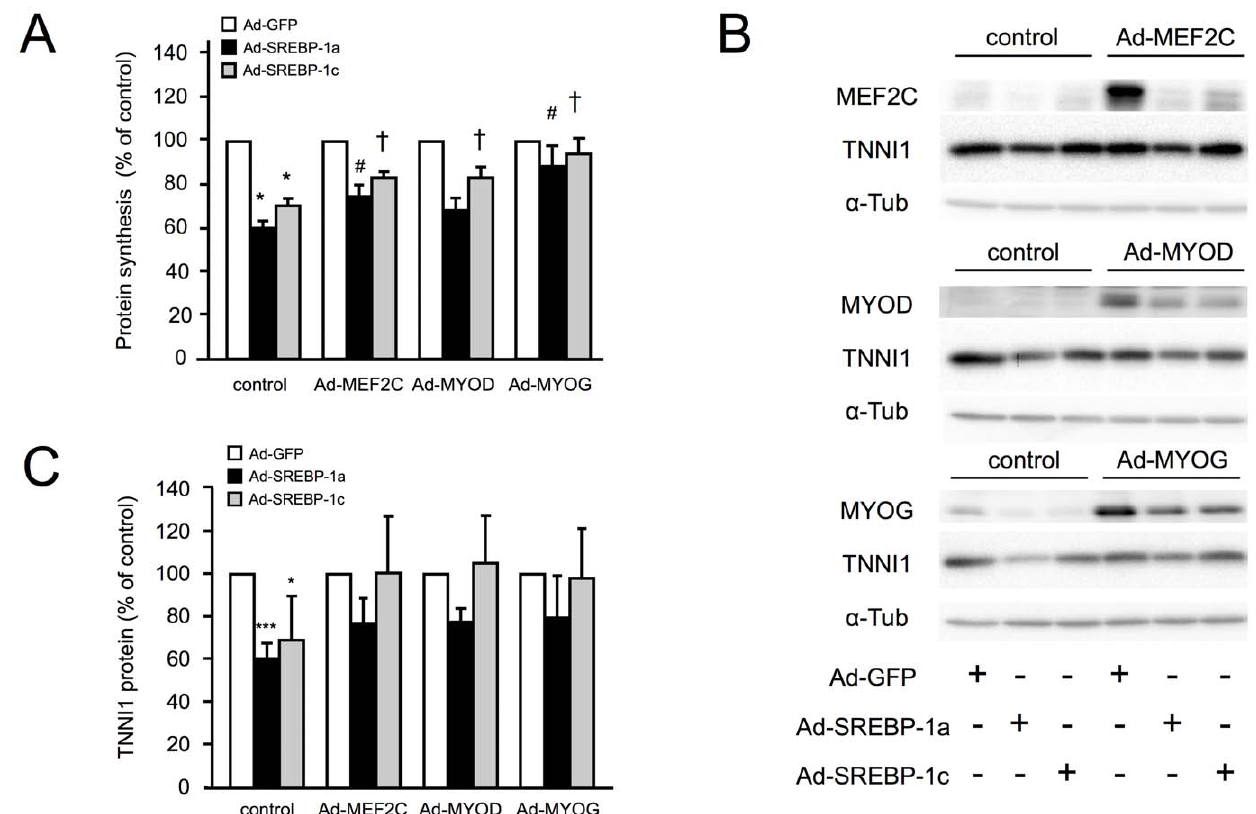
Figure 4. Expression of MEF2C, MYOD1 and MYOG are necessary to maintain muscle cell protein synthesis and expression of sarcomeric proteins. Human myotubes were infected for 48 h with recombinant adenoviruses encoding GFP (white), SREBP-1a (black) or SREBP-1c (grey) in combination with viruses expressing MEF2C, MYOD1, MYOG or GFP (control). (A) Protein synthesis rates were measured in all different conditions. The results are the means 6 SE of 5 determinations. *p , 0.001 compared to Ad-GFP infected cells. # p , 0.05 compared with Ad-SREBP-1a alone ; { p , 0.05 compared with Ad-SREBP-1c alone (B) Representative images of TNNI1 immuno-detection by western blotting from total cell extract of myotubes. (C) Quantification of TNNI1 content in each condition, normalized by tubulin and expressed as percentage of control. The results are the means 6 SE of 3 determinations.